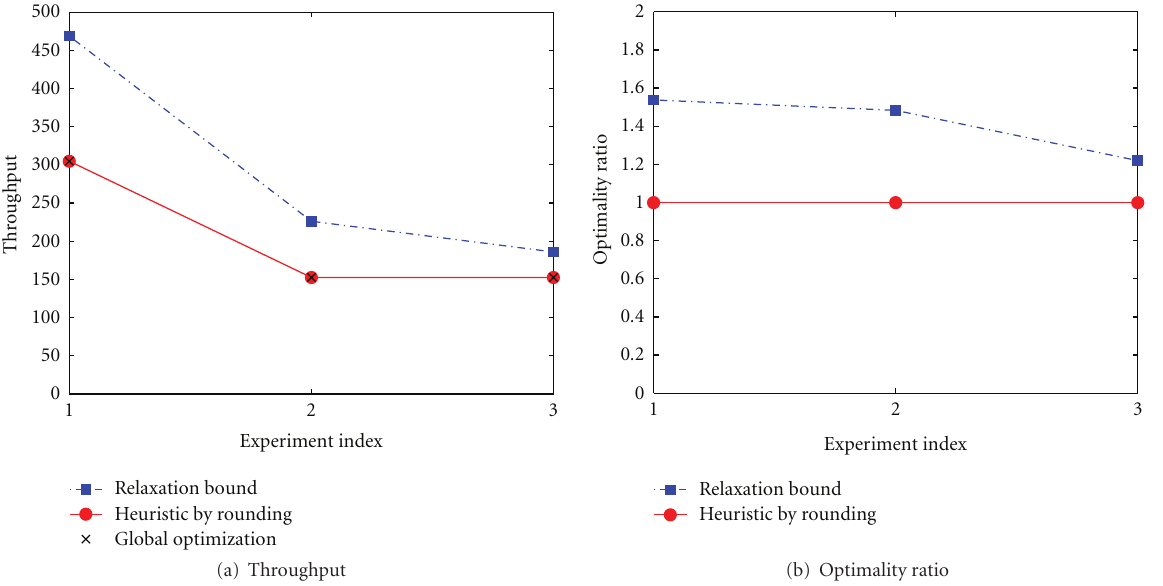
Figure 5: Comparison between heuristic, upper bound and global optimum for regular